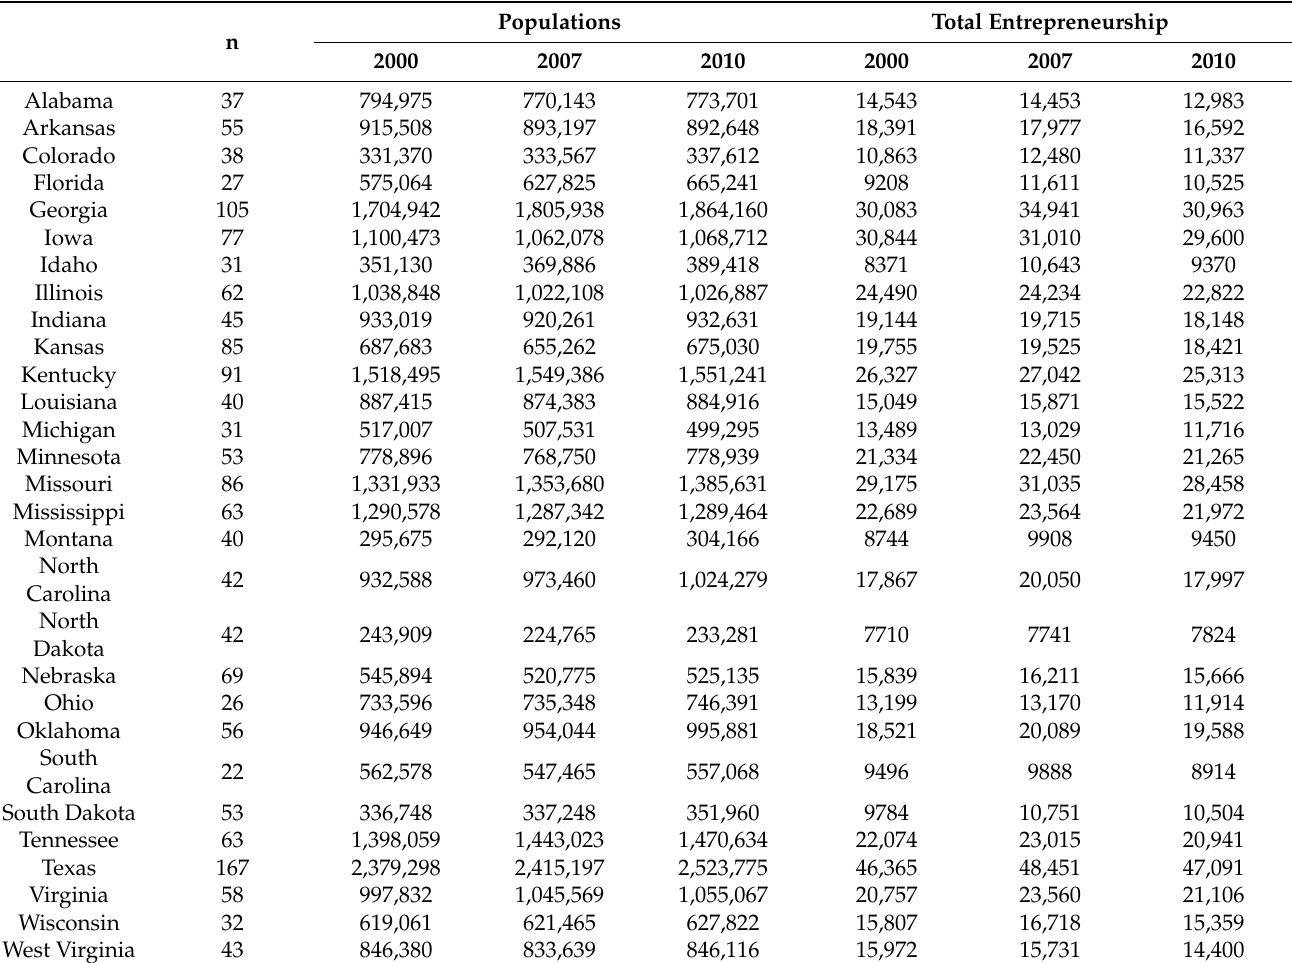
Table 4. The population and total entrepreneurship values in 2000, 2007, and 2010 of U.S. states with 20 or more counties among the selected group of 1785 counties. Growth phase = 2000 to 2007; The recession = 2007 to 2010; n = number of counties with new entrepreneurship values between 30 and 250. Data of the same counties was analyzed for 2000, 2007, and